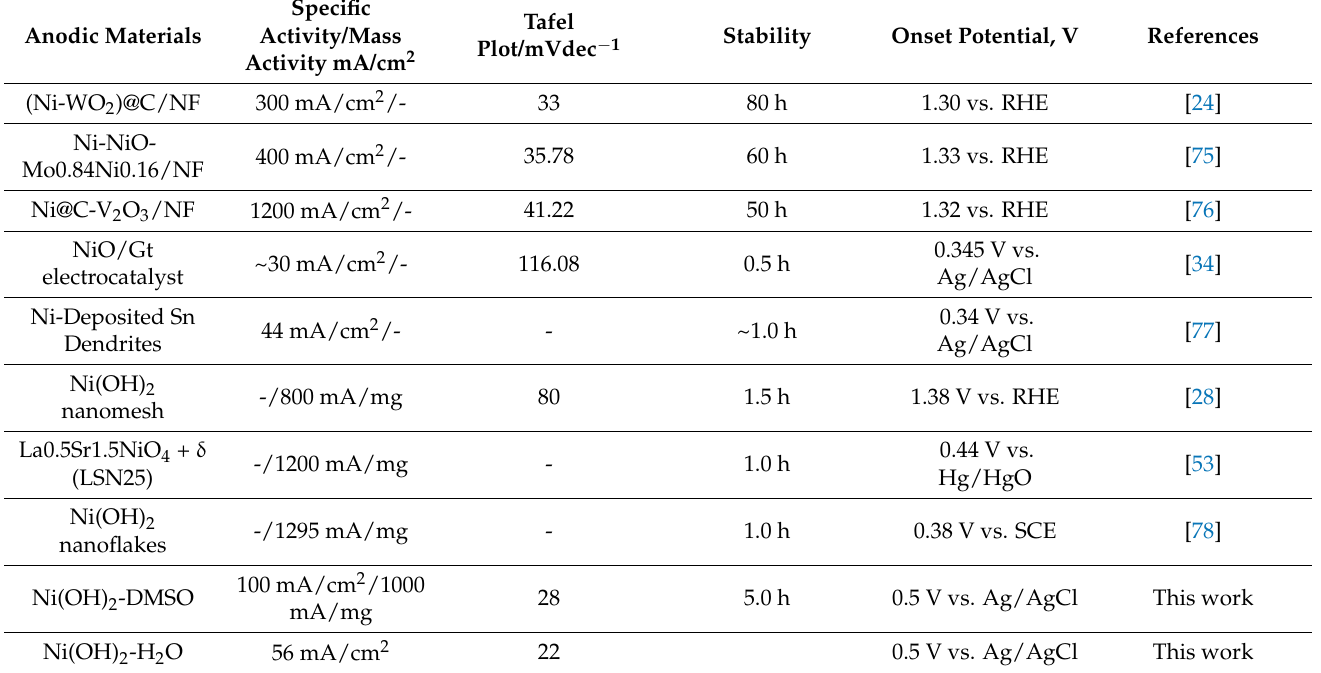
Table 2. Comparison of the electrocatalytic UOR of various nickel-containing catalysts in 0.33 M urea/1.0 M KOH according to CV